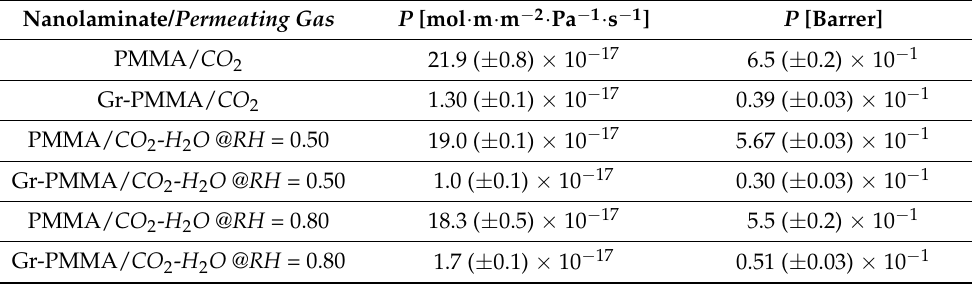
Table 2. Permeability coefficients of O 2 through the nanolaminates at different R.H. levels.